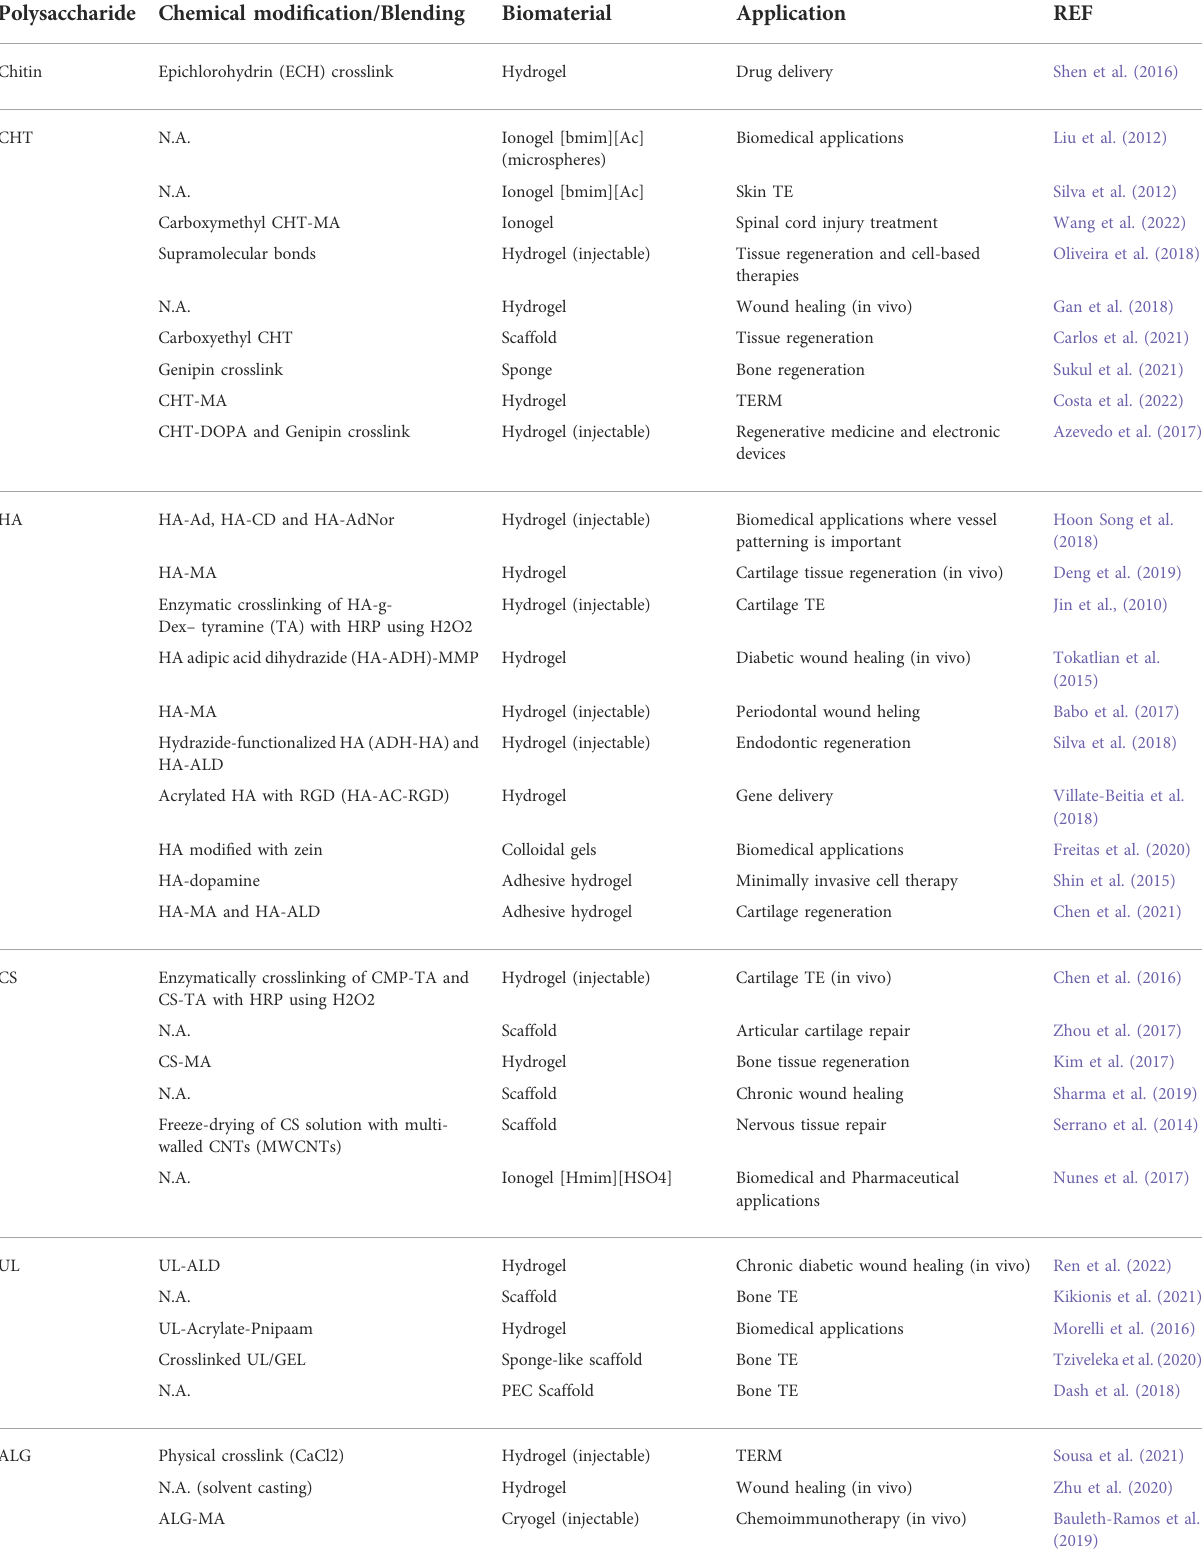
TABLE 5 Hydrogel-derivatives processed from marine for biomedical